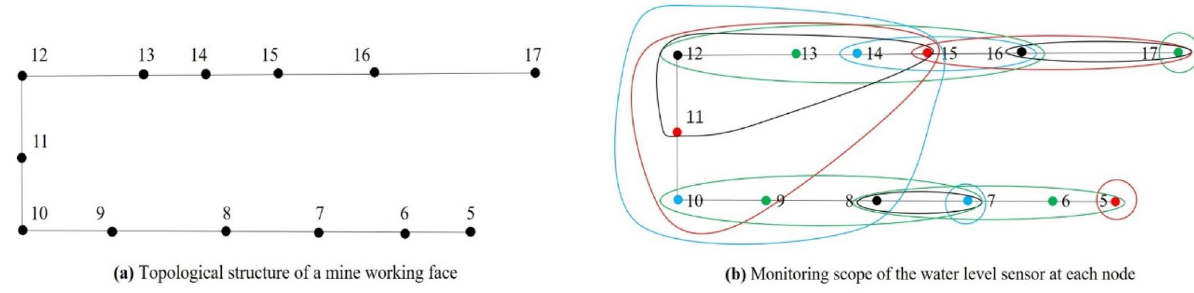
Figure 4. Monitoring scope of each node in a mine working face.